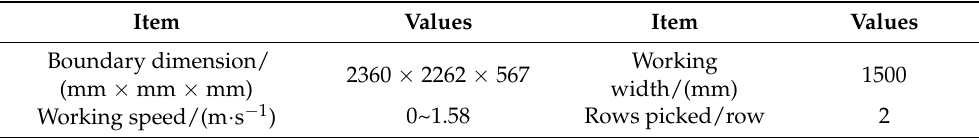
Table 1. Main technical parameters of the castor harvester picking device.